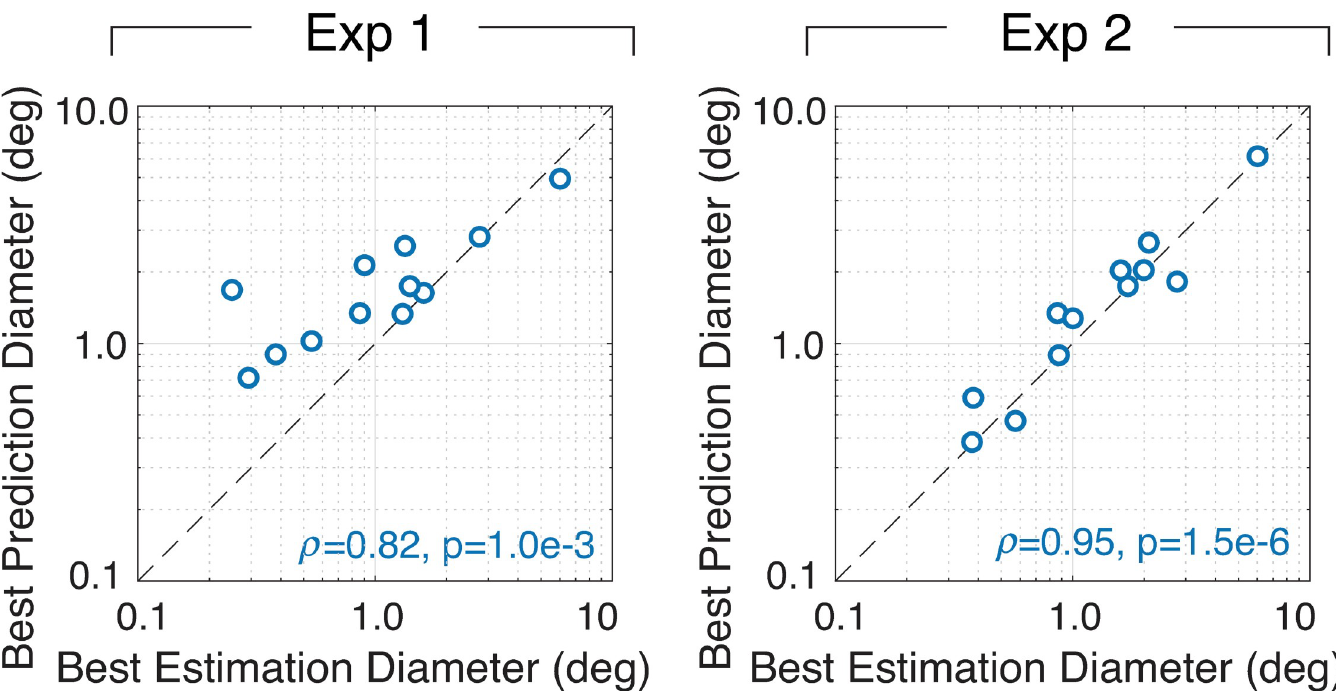
Fig 12. Pooling sizes that maximize groundtruth tilt estimation performance vs. pooling sizes that maximize the prediction of human performance. Pooling diameters that maximize estimation performance predict those that maximize the prediction of human performance. Each data point represents the diameter that maximizes performance for a different groundtruth tilt at the target location (cf. Fig 11). The actual sizes of the pooling regions that maximize estimation performance are similar to the sizes that maximize the prediction of human